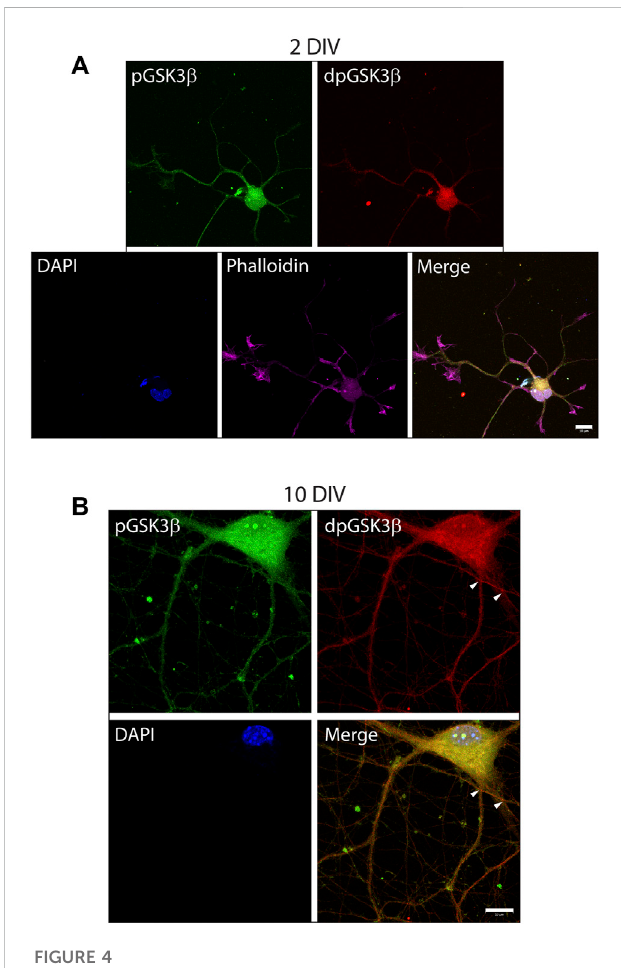
Active phospho-Ser9-GSK3 β is localized at speci fi c locations in developing neurons. WT hippocampal neurons cultured for 2 (A) or 10 DIV (B) were stained for inactive phosphor-Ser9-GS3 β (green), active dephospho-Ser9-GSK3 β (red), and actin (phalloidin). In early development punctate staining of inactive pGS3 β is visible along the length of the growing neurites whereas active dp-GSK3 β has more limited localization (A) . In laterdevelopment,active dpGSK3 β islocalized at speci fi c subdomains of the axon at points of axonal crossing ( B , arrowheads), as well as in the cell body. Scale bars: 10 μ